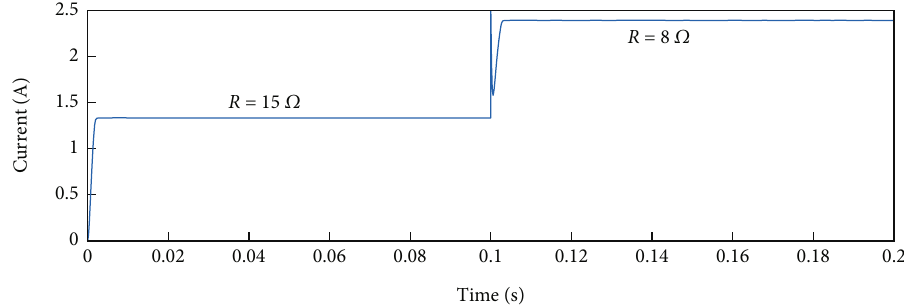
Figure 21: Response of the PVE to an abrupt change in load resistance (current).